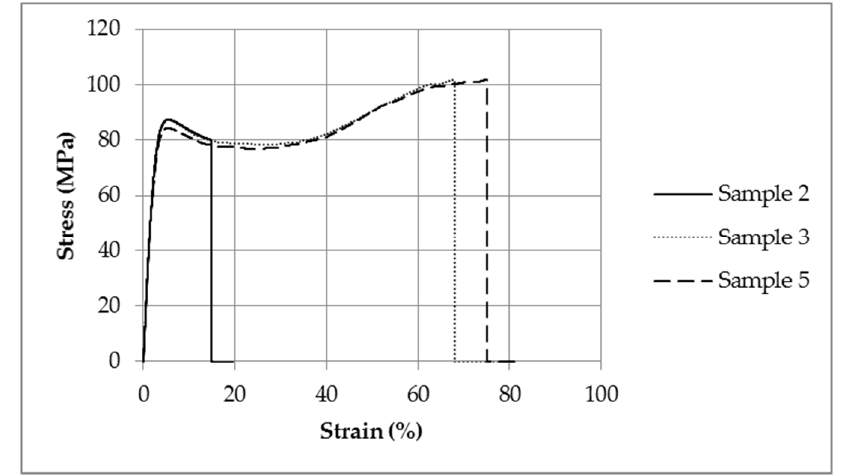
Figure 4. Typical stress-strain plot for three samples of 1 mm PMMA fibre tested to failure at a strain rate of 0.25/min (crosshead travel 50 mm/min). Note early failure of Sample 2.